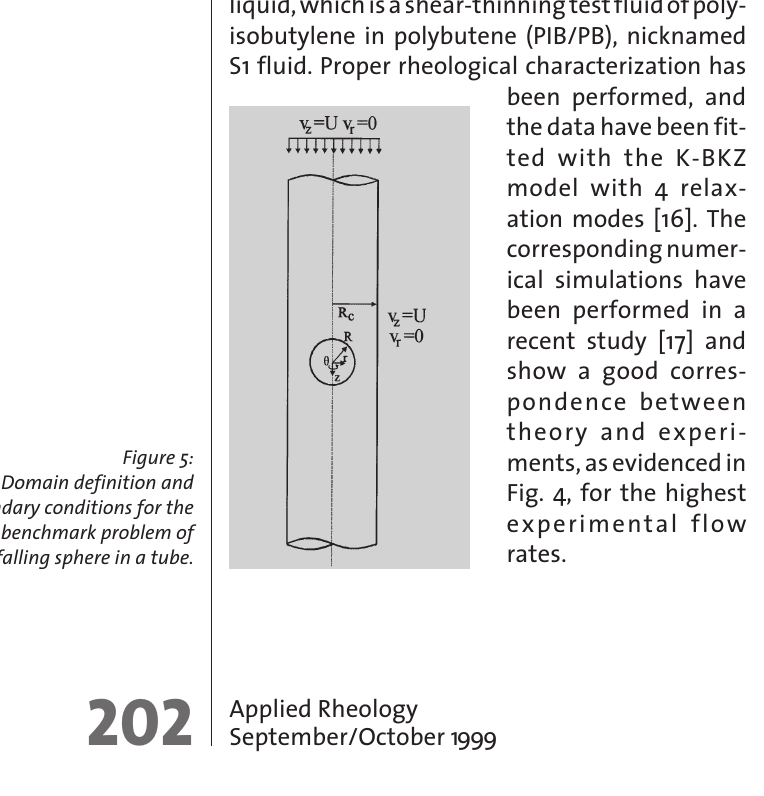
Figure 5: Domain definition and boundary conditions for the benchmark problem of falling sphere in a